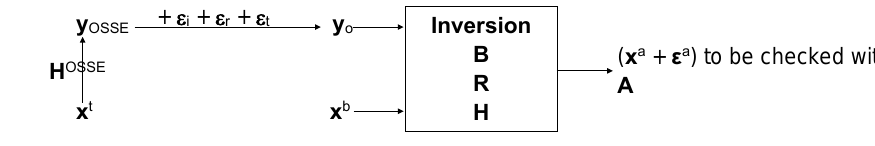
Figure 3. Schematic of the OSSEs. Table 1. Setup and performance indicators of the two types of inversions. Input of inversions INV-N INV-E Performance indicators